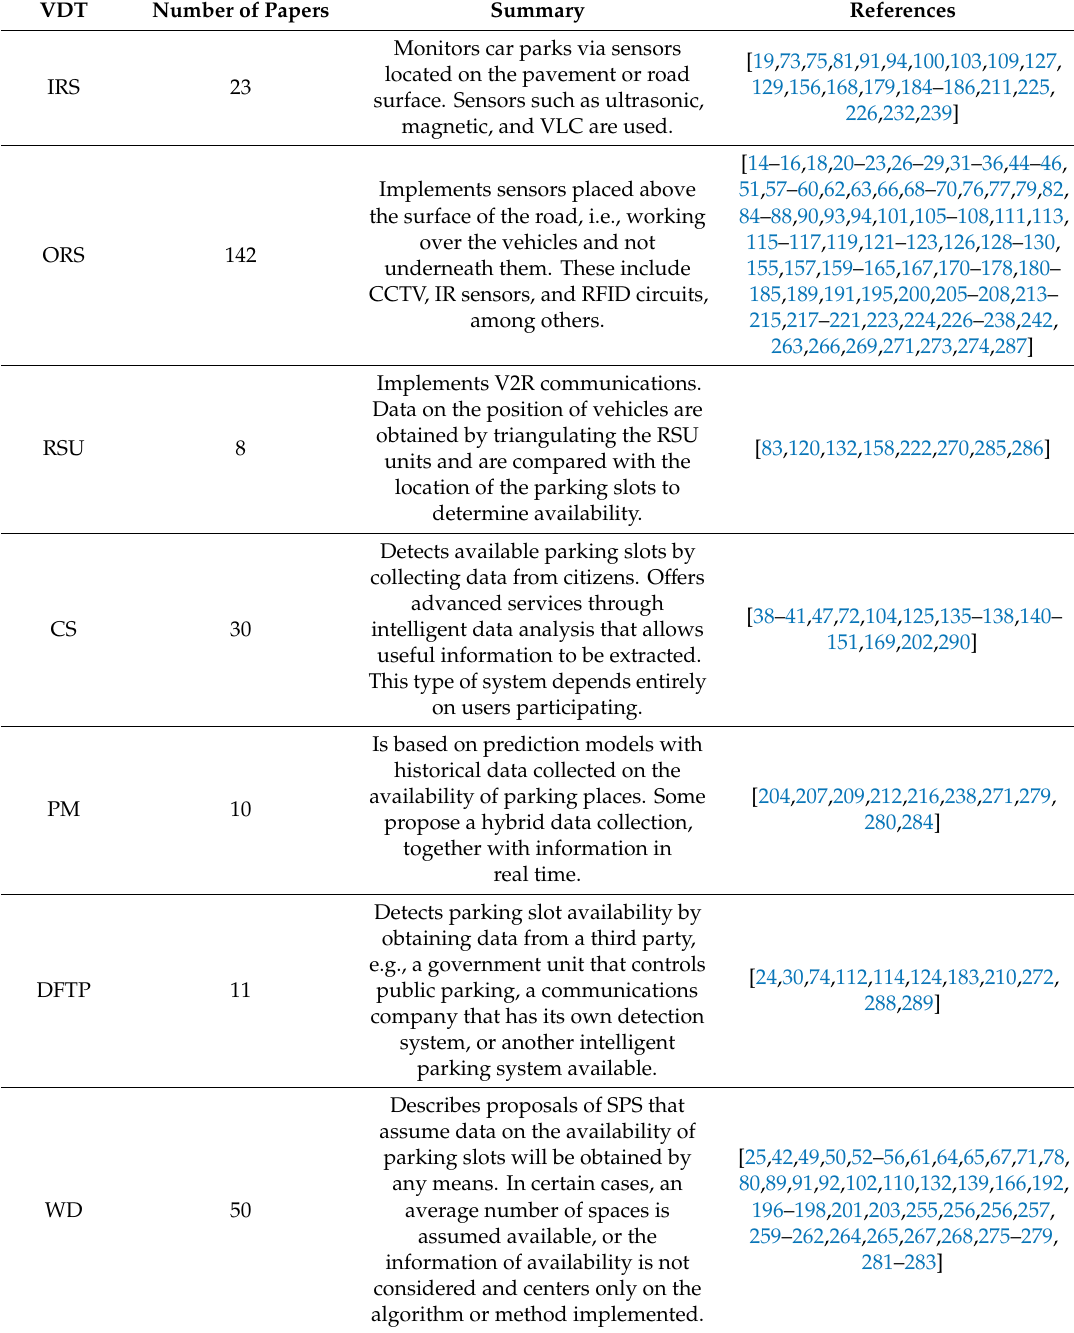
Table 9. Number of publications for each VDT, along with a summary and